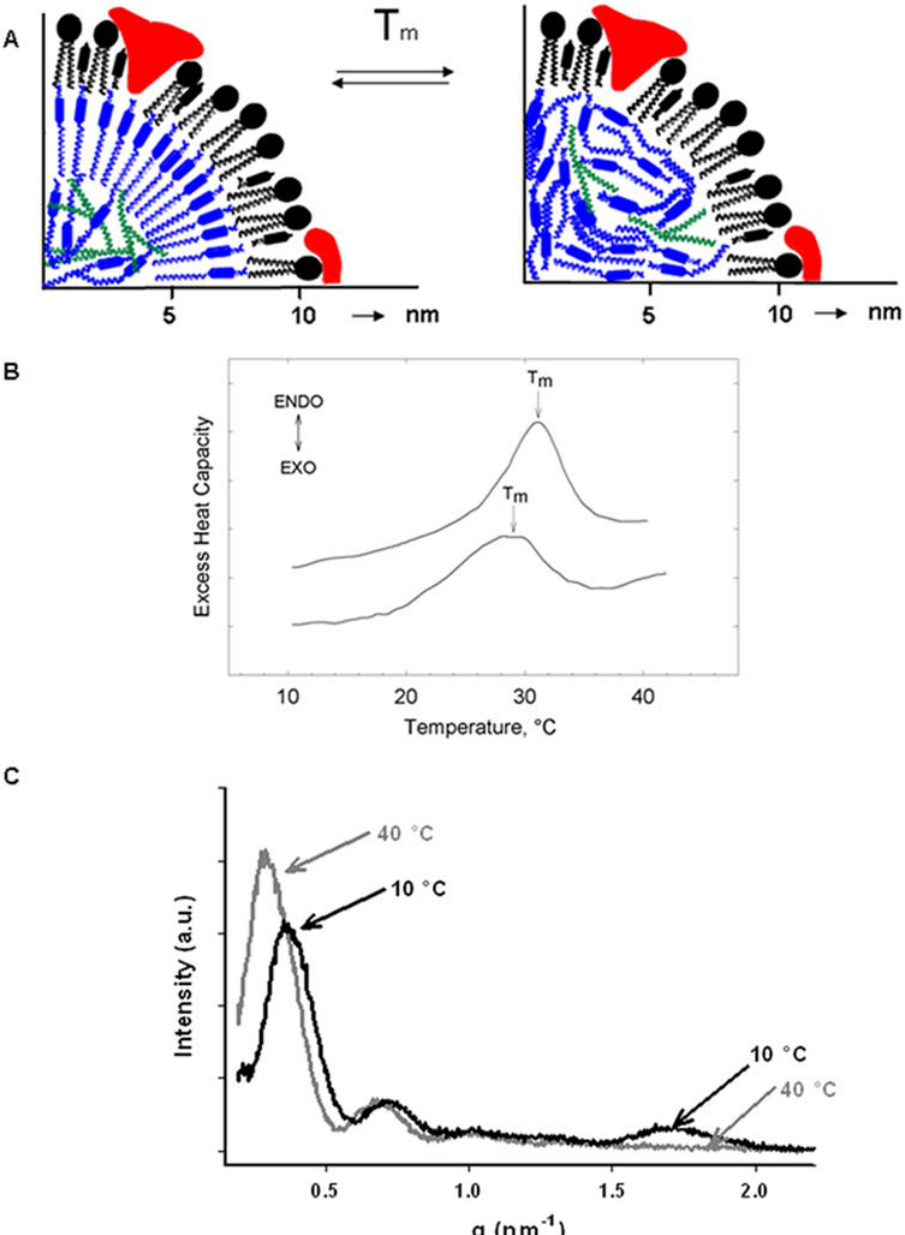
Figure 2. LDL nanophase transition. (A) Schematic of the thermotropic crystalline to isotropic transition in the apolar core lipids of LDL. Below Tm, the cholesteryl ester and triglyceride molecules (shown in blue and green, respectively) are arranged in two layers with a 3.6 nm repeat distance (left panel). Above Tm, the core lipids are in a fluid, oily state (right panel). The core lipids are surrounded by a monolayer of phospholipids and a single copy of apolipoprotein B100 (drawn in black and red, respectively). (B) Tm is typically determined by differential scanning calorimetry. The thermotropic transition is directly reflected in the small angle X-ray scattering curves. Static measurements performed at the SAXS – beamline at ELETTRA at 10 u C and at 40 u C are shown in (C). Upon heating above Tm, the intensity of the 1st side-maximum increases, and the 5th side-maximum vanishes. All scattering curves were recorded in the q-range of 0.09 , q , 2.30 nm-1 (q=4 p sin( h )/ l , where 2 h is the scattering angle and l the wavelength, l =0.15